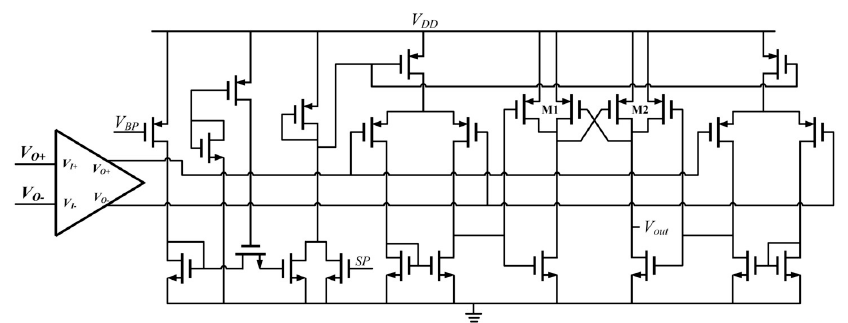
Figure 9. Scheme of the differential-to-single-ended converter.